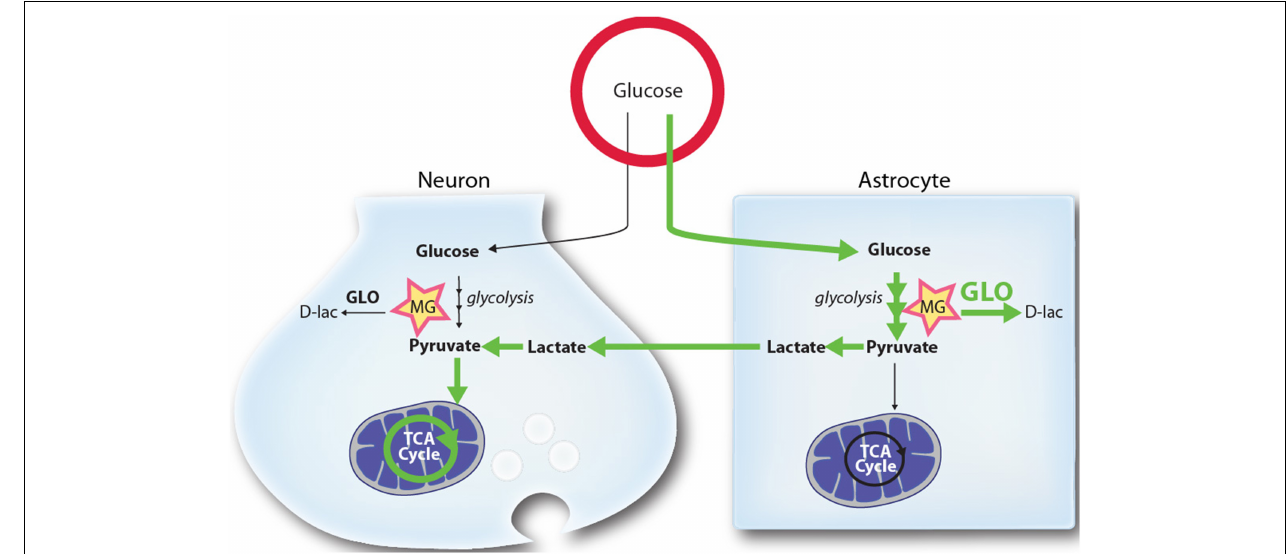
FIGURE 3 | Schematic representation of the proposed mechanism by which higher glycolytic rates in astrocytes may provide a mechanism limiting MG toxicity in neurons. Glycolysis in both astrocytes and neurons leads to the production of the toxic MG by-product. MG is detoxified by both cell types through the glyoxalase system (GLO), producing D-lactate (D-lac). In normal and stimulated conditions (ANLS) glucose utilization and its processing through the glycolysis is tilted toward astrocytes, which release L-lactate (lactate) that can be used by neurons as a mitochondrial energy substrate. Due